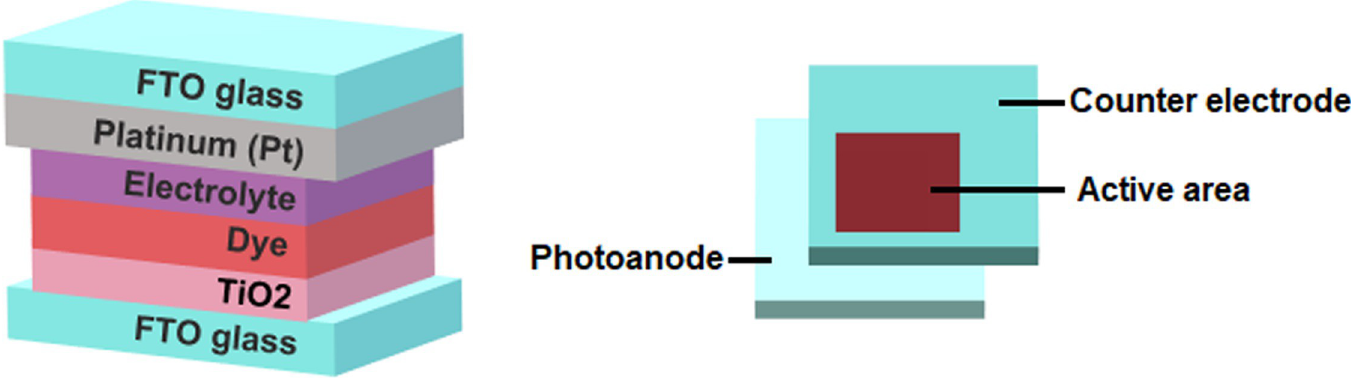
Fig 2. A schematic diagram of the DSSC